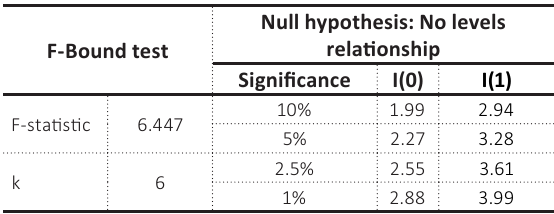
Table 5. F-Bound test for non-linear cointegration